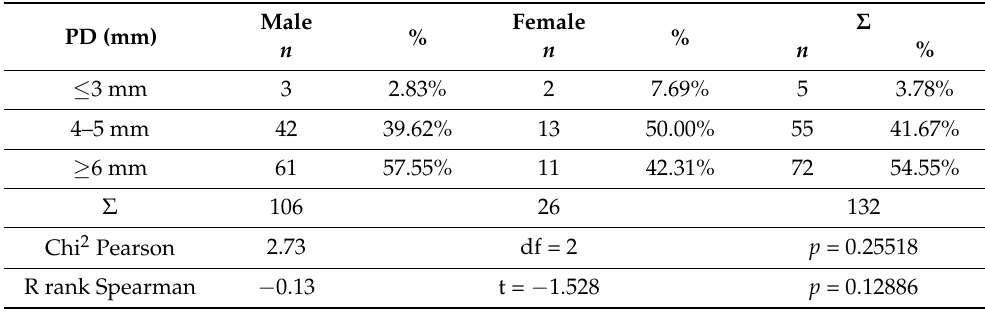
Table 2. Characteristics of the study population concerning periodontal pocket (PD) depth at inter- proximal sites by